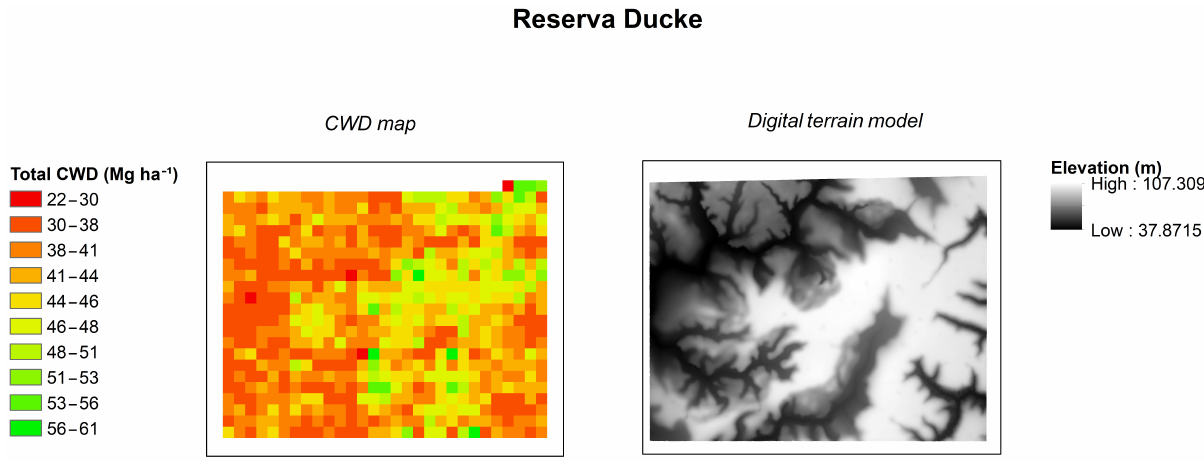
Figure A1. Wall-to-wall map of total CDW and digital terrain model at the DUC